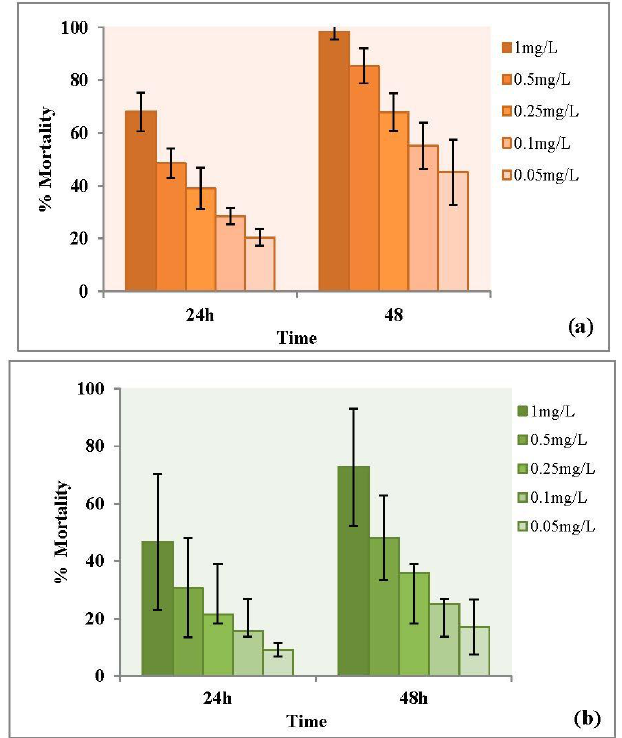
Figure 10. Acute toxicity by nanoparticles ( a ) engineered CuO and ( b ) plant-synthesized CuO (Mean ± SD) ( n = 3)). Table 2. EC 50 acute toxicity of engineered and plant CuO NPs.